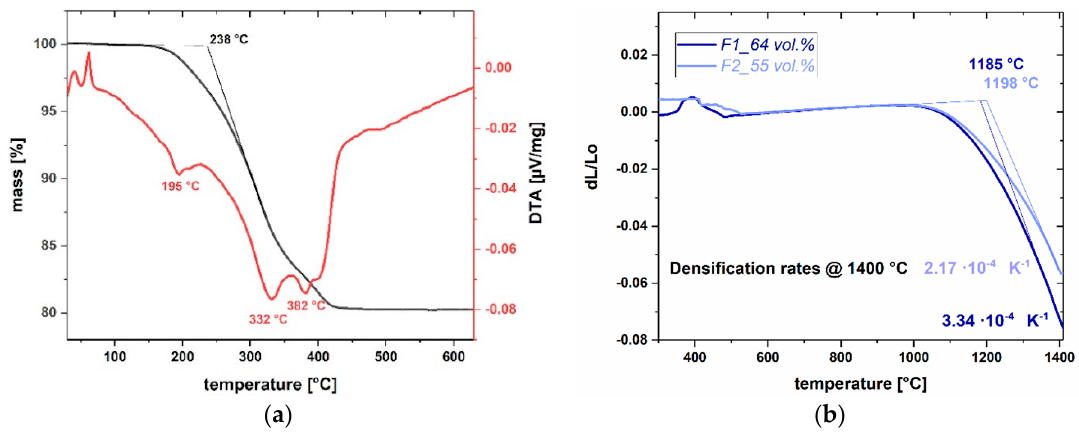
Figure 9. Thermogravimetric analysis of the feedstock according to formula II with an alumina powder load of 55 vol.% ( a ) and dilatometric measurements on alumina feedstocks containing 55 vol.% or 64 vol.% alumina powder ( b ).